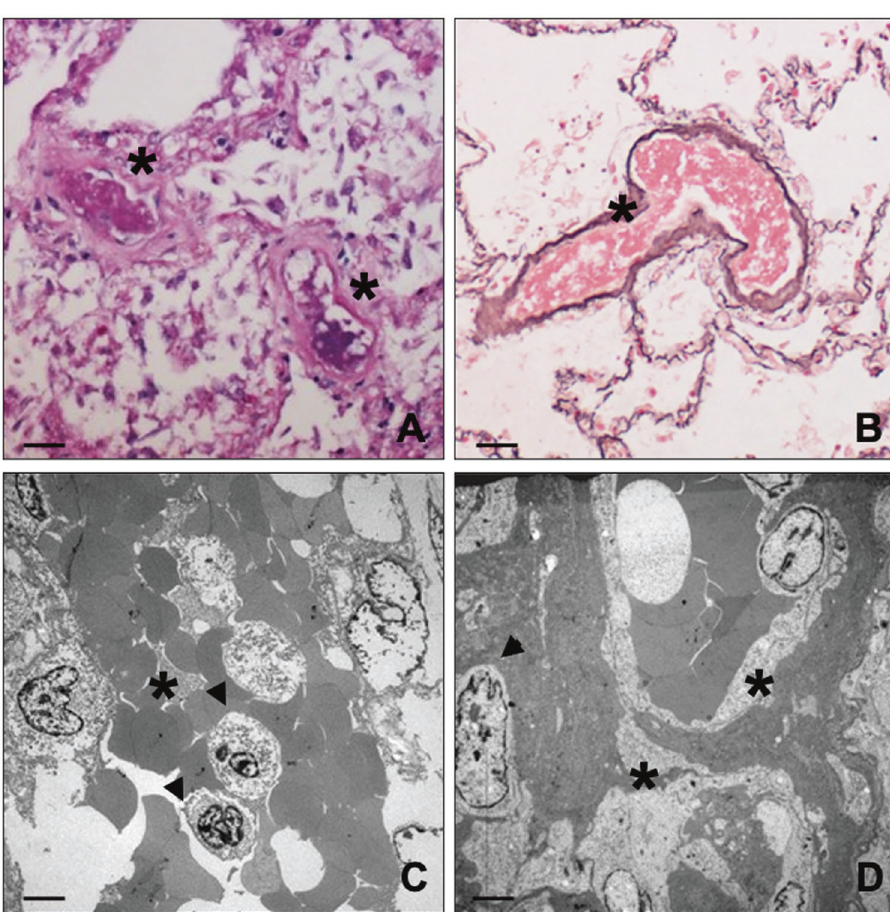
Fig. 3 Histological analysis of lung thrombi. A – D Histological and electron microscopy analysis of lung tissues. Both PAS ( A ) and silver ( B ) staining show vascular thrombi (asterisks) in lung capillaries (scale bar 100 µm). C Electron micrograph shows vascular thrombi characterized by microvascular fi brin deposition (asterisks). The thrombi include degenerated monocytes (arrows) (scale bar 5 µm). D Image displays vascular thrombi with microvascular fi brin deposition (asterisks) and well-preserved pericytes (arrows) (scale bar 5